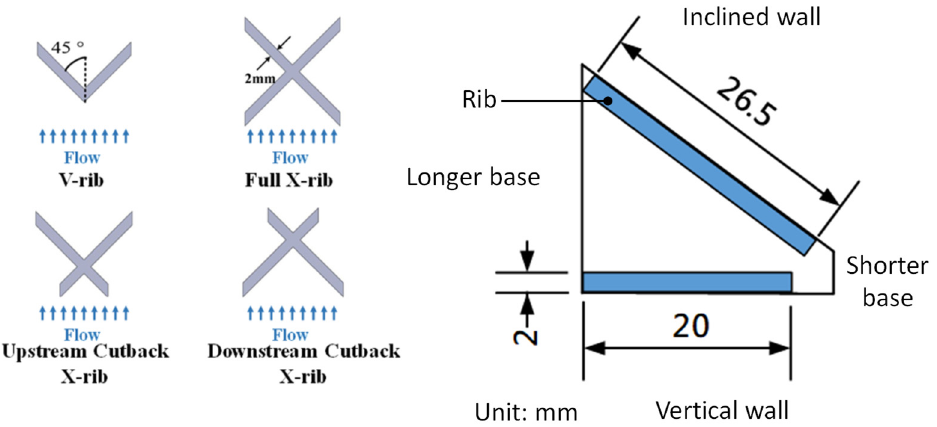
Figure 3. Drawing of the test section.